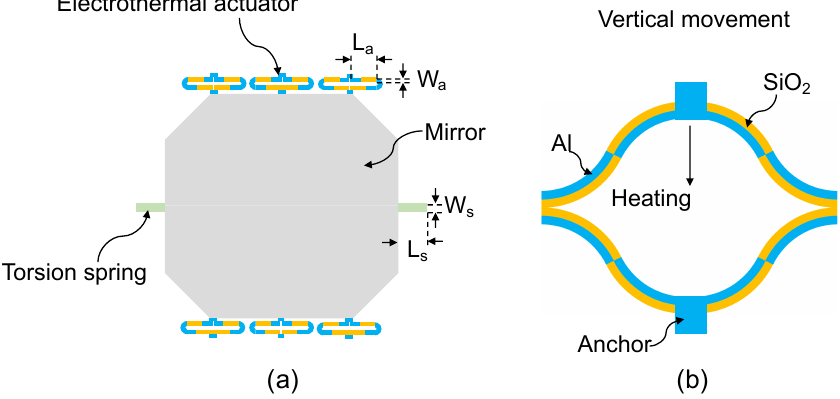
Figure 1. ( a ) Schematic of the electrothermal microelectromechanical systems (MEMS) mirror. ( b ) Side view of the bilaterally symmetrical folded double S-shaped bimorph (FDSB) electrothermal actuator.